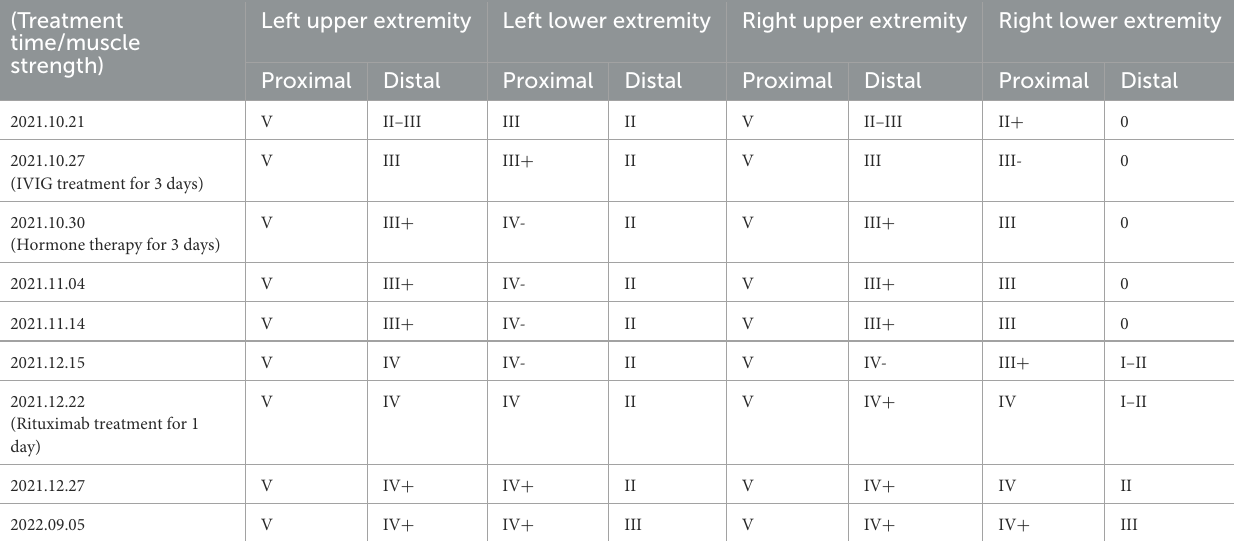
TABLE 3 Change in muscle strength between patient admissions. (Treatment